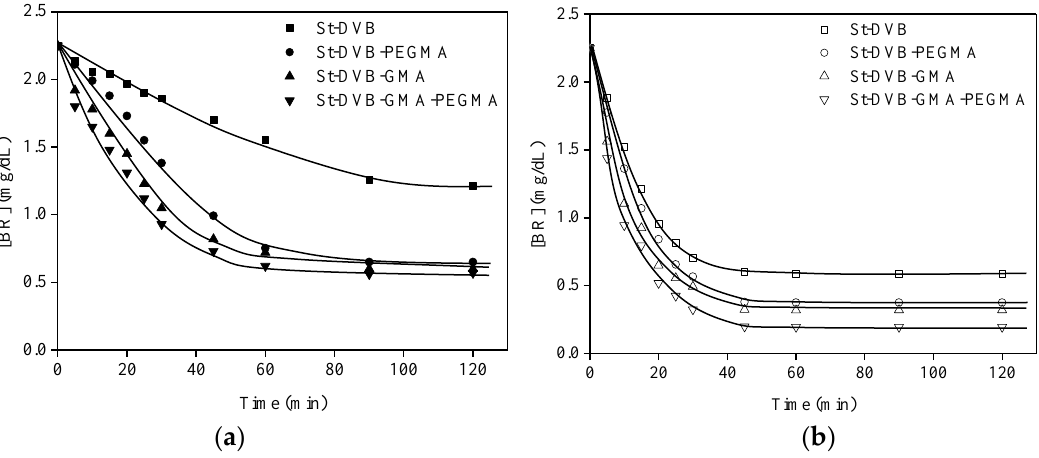
Figure 6. Kinetics of BR removal in St-DVB pre-wetted particles without ( a ) and with BSA ( b ). Experiments without BSA were carried out with 2 g of particles and the experiments with BSA were carried out with 1.5 g of particles. T = 25 °C and Fr = 120 mL/min. Table 3. Amount of removed bilirubin from PBS in particles without and with BSA wetted in ethyl lactate.